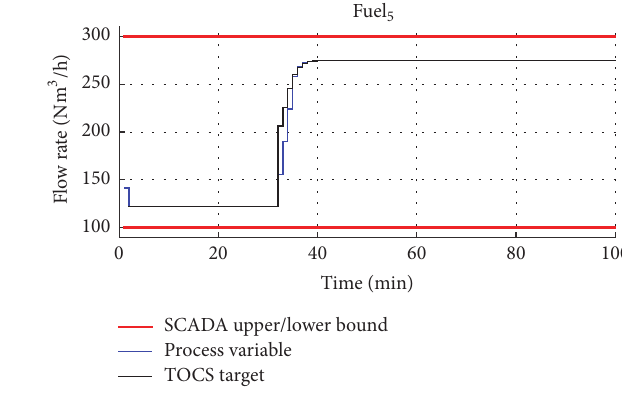
Figure 7: Zone 5 fuel flow rate trends.